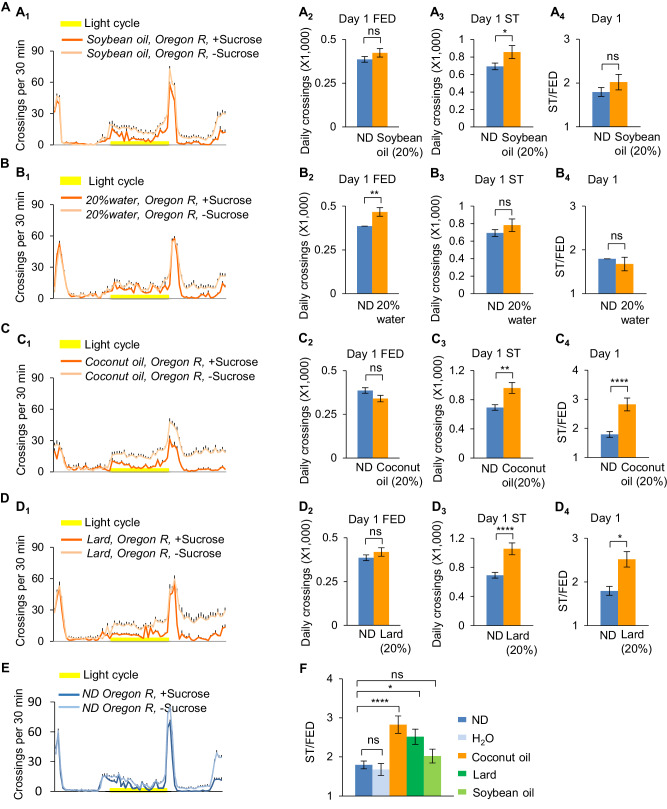
Dietary saturated fat promotes starvation-induced hyperactivity.Wild-type Oregon-R virgin female flies fed with normal fly food (ND, blue) or different types of lipids (orange) were assayed in the presence (dark color) and absence (light color) of 5% sucrose using DAMS-based locomotion assay (n = 39–63). Midline crossing activities of indicated flies are shown in A1, B1, C1, D1, and E. (A2, B2, C2, D2) Average daily midline crossing activity of fed flies assayed in A1, B1, C1, D1, and E. (A3, B3, C3, D3) Average daily midline crossing activity of starved flies assayed in A1, B1, C1, D1, and E. (A4, B4, C4, D4) Starvation-induced hyperactivity of flies assayed in A1, B1, C1, D1, and E. (F) A summary of the effect of different oil feeding. Note that data shown in E are the same as data shown in Figure 1—figure supplement 2D. ns, p>0.05; *p<0.05; **p<0.01; ****p<0.0001. Student’s t-test and one-way ANOVA followed by post hoc test with Bonferroni correction were used for pair-wise and multiple comparisons, respectively.